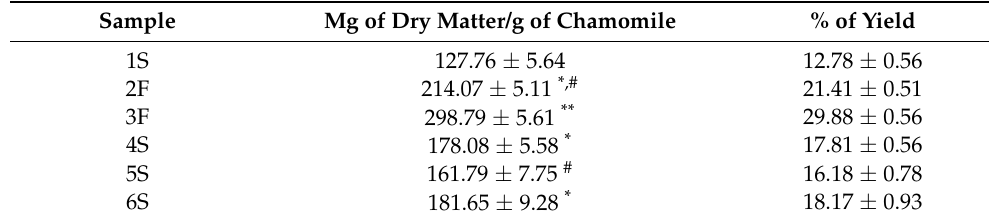
Table 1. Yields of chamomile sample